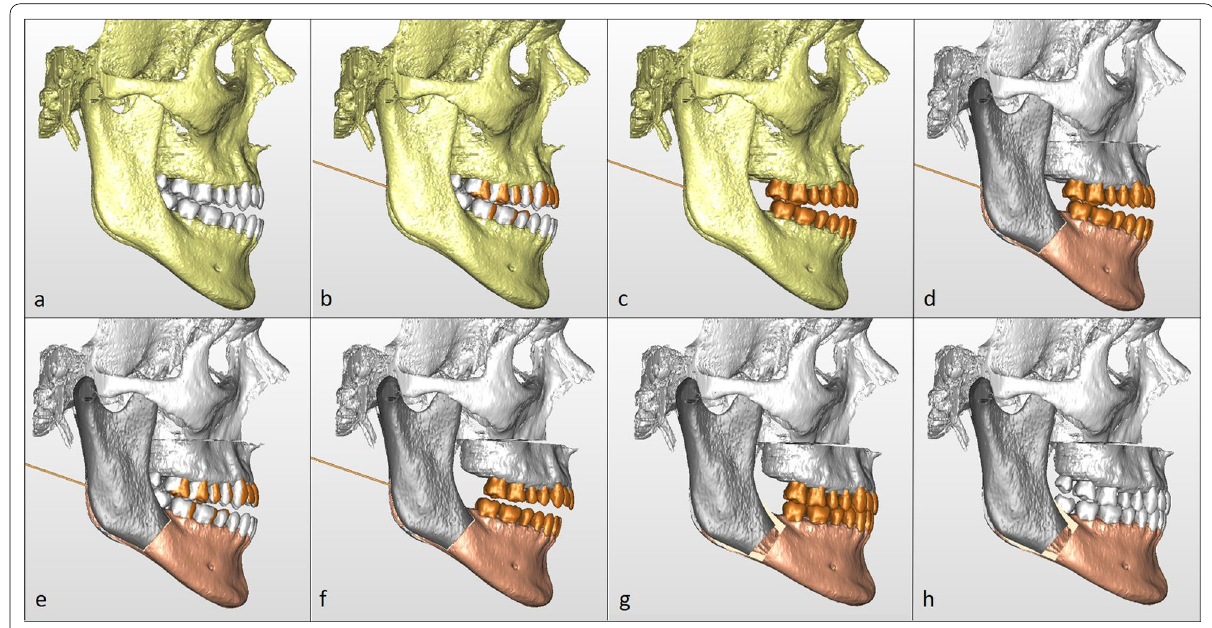
Fig. 9 VOSP wokflow. Figures are labelled form top left to bottom right. A , Patient 3D reconstruction; B , The ideal virtual arches of both arches were registered on the skeletal base, superimposed on the native arches; C , Skeletal base with ideal virtual arches; D , E , Virtual osteotomy of the base of the facial skeleton with ideal virtual arch and both ideal and native; F , Virtual surgical plan: repositioning of the upper jaw, followed by the virtually planned dental arches; G , Positioning of the lower jaw by reference to the ideal virtual occlusion; and H upper and lower jaw surgical virtual planning with native arches